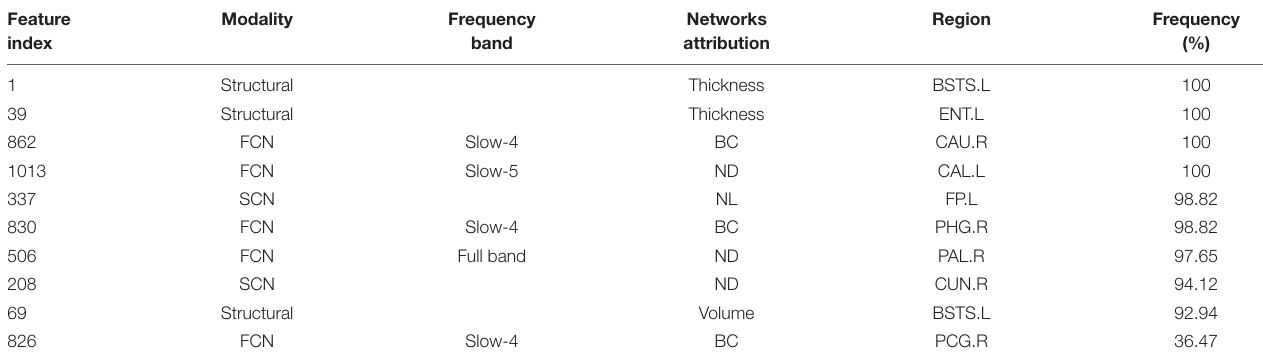
TABLE 6 | Selected feature distributions in the MCInc vs. MCIc group using the RSFS algorithm. Feature index